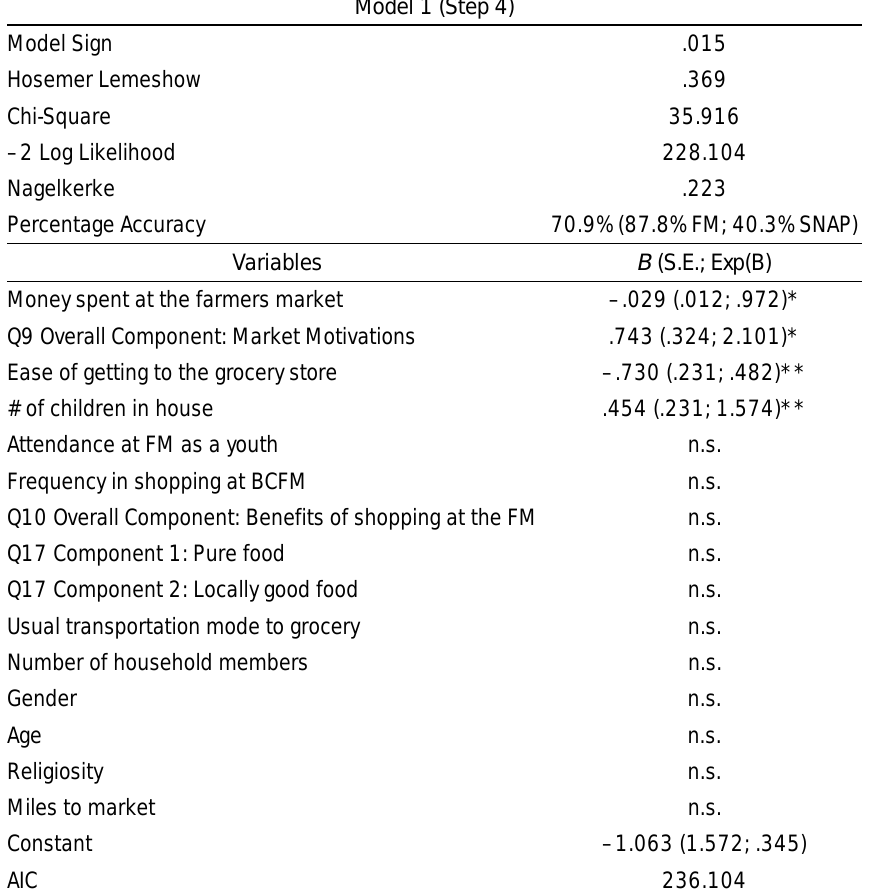
Table 5. Summary Statistics of the Binary Logistic Regression Model to Predict SNAP User Status Among Farmers Market